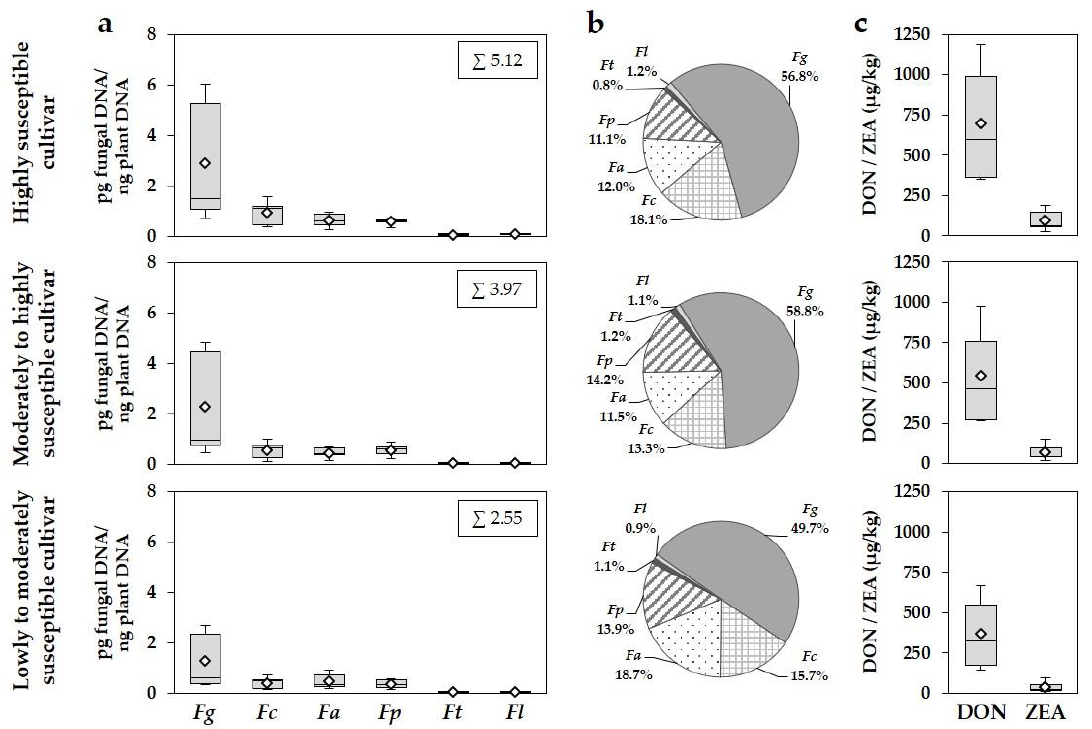
Figure 4. Boxplots and means (white rhombus) of ( a ) DNA amounts of F. graminearum ( Fg ), F. culmorum ( Fc ), F. avenaceum ( Fa ), F. poae ( Fp ), F. tricinctum ( Ft ) and F. langsethiae ( Fl ) (pg fungal DNA / ng plant